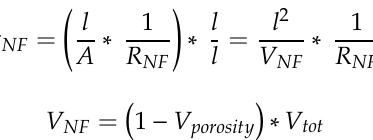
Figure S1: Scheme of the experimental procedure, Figure S2: TGA and DTA profiles, Figure S3: EDS analysis of CGO600, Figure S4: Zoom on (111) plane, Figure S5: High magnification SEM images of (a) CGO green, (b) CGO500, (c) CGO600, (d) CGO700, (e) CGO800, and (f)